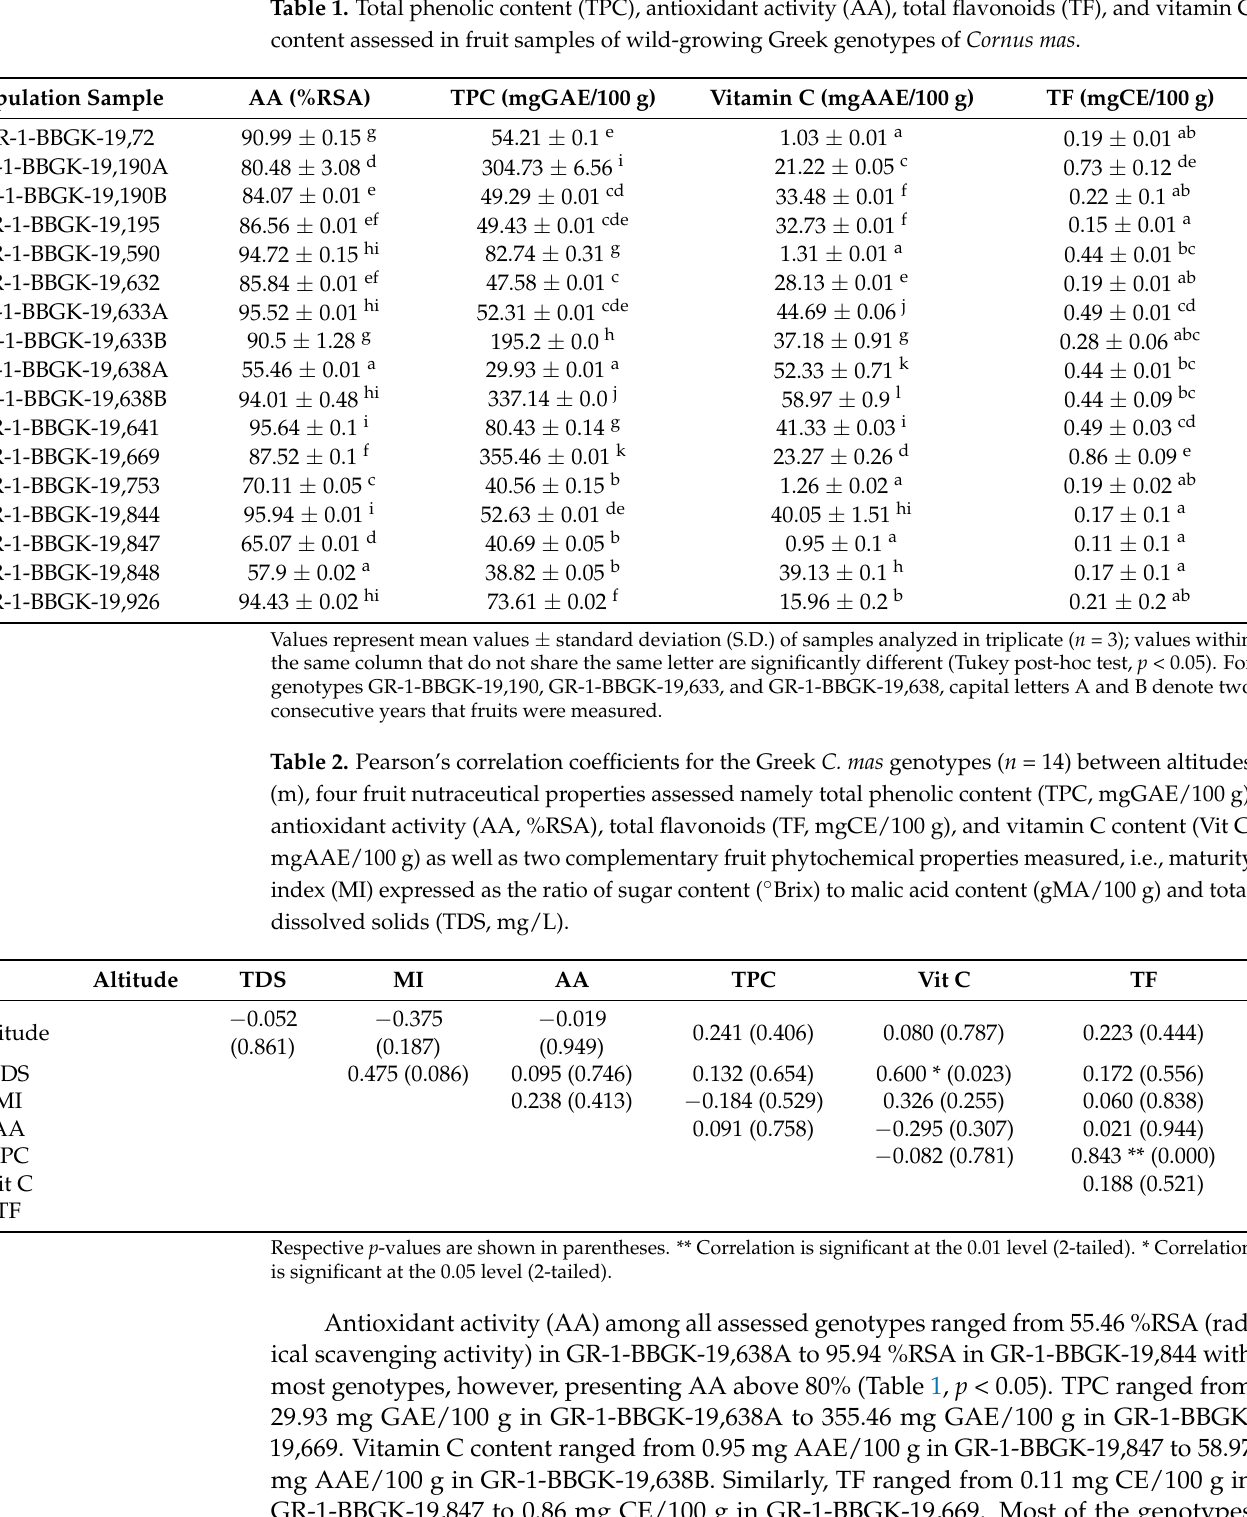
Table 1. Total phenolic content (TPC), antioxidant activity (AA), total flavonoids (TF), and vitamin C content assessed in fruit samples of wild-growing Greek genotypes of Cornus mas .